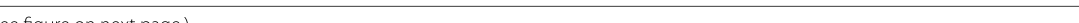
figure on next Fig. 6 HMGB1 in the mPFC was sufficient to induce anxiety‑like behaviors and aversion but not pain sensitization in naïve mice. a Schedule of experimental procedures. b Paw withdrawal thresholds to mechanical stimulation and noxious heat stimulation at the left hind paw and head withdrawal threshold to noxious heat stimulation at the left vibrissal pad. c, d Anxiety‑like behaviors measured by EPM, LDB and OFT on D8/9 ( c ) and D15/16 ( d ) after administration. e Representative heat maps in the CPP test. f Time spend by mice in the saline‑ and ds‑HMGB1‑paired boxes. *, ** and *** indicate P < 0.05, 0.01 and 0.001, respectively, compared with the saline‑treated group in ( c ) and pre‑conditioning in ( f ), unpaired t test. n =